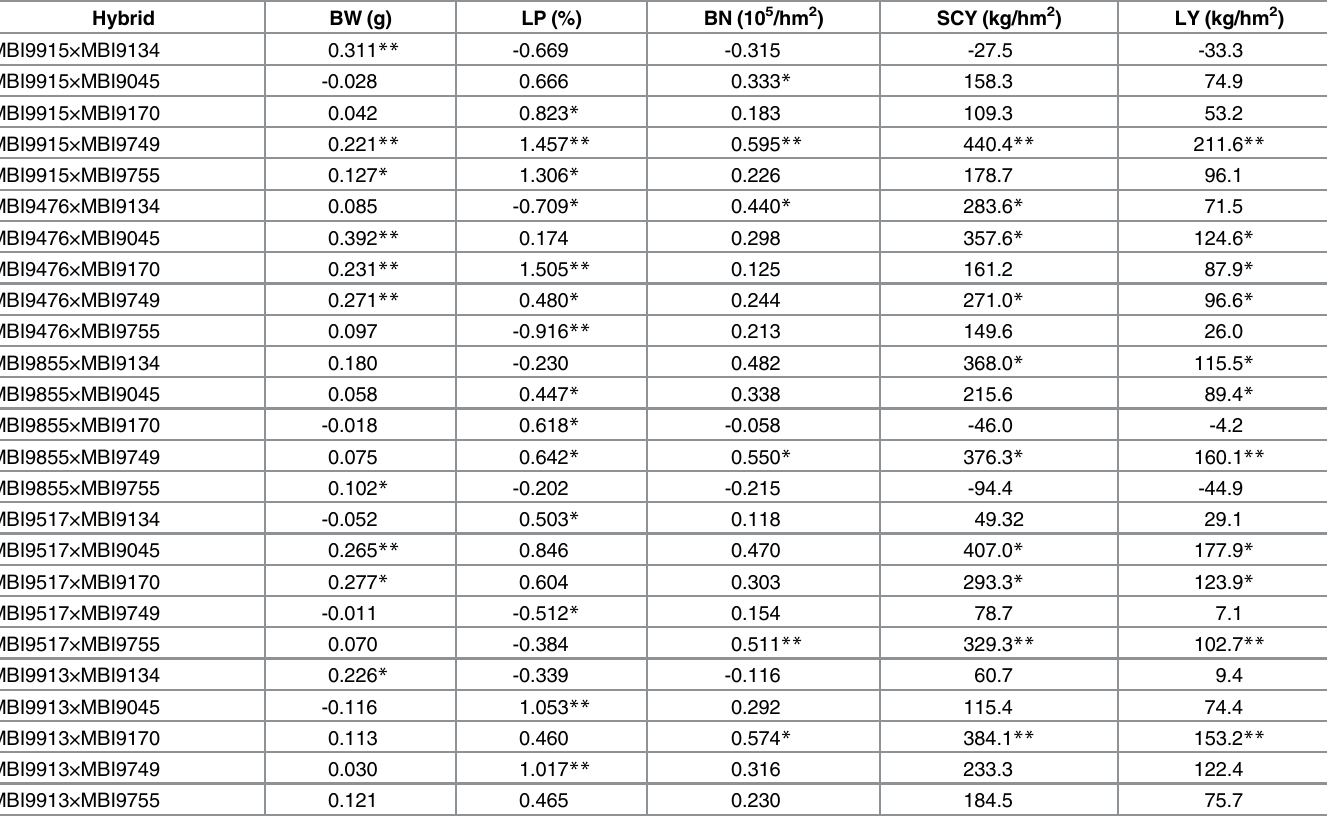
Table 4. Heterozygous dominance effects of F 1 for yield and yield components in PopCCRI36.